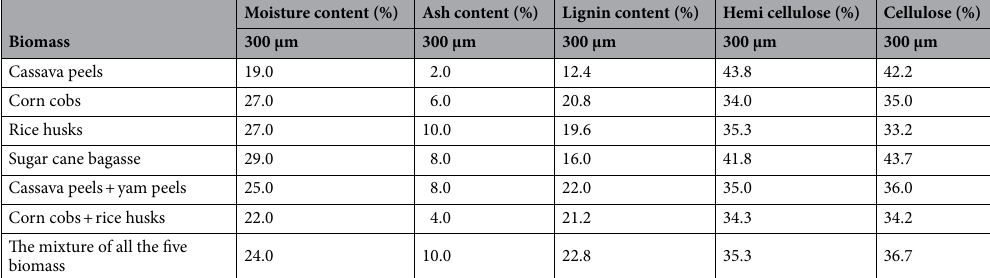
Table 3. Proximate analysis result for hydrothermal and alkali-based pretreated samples.